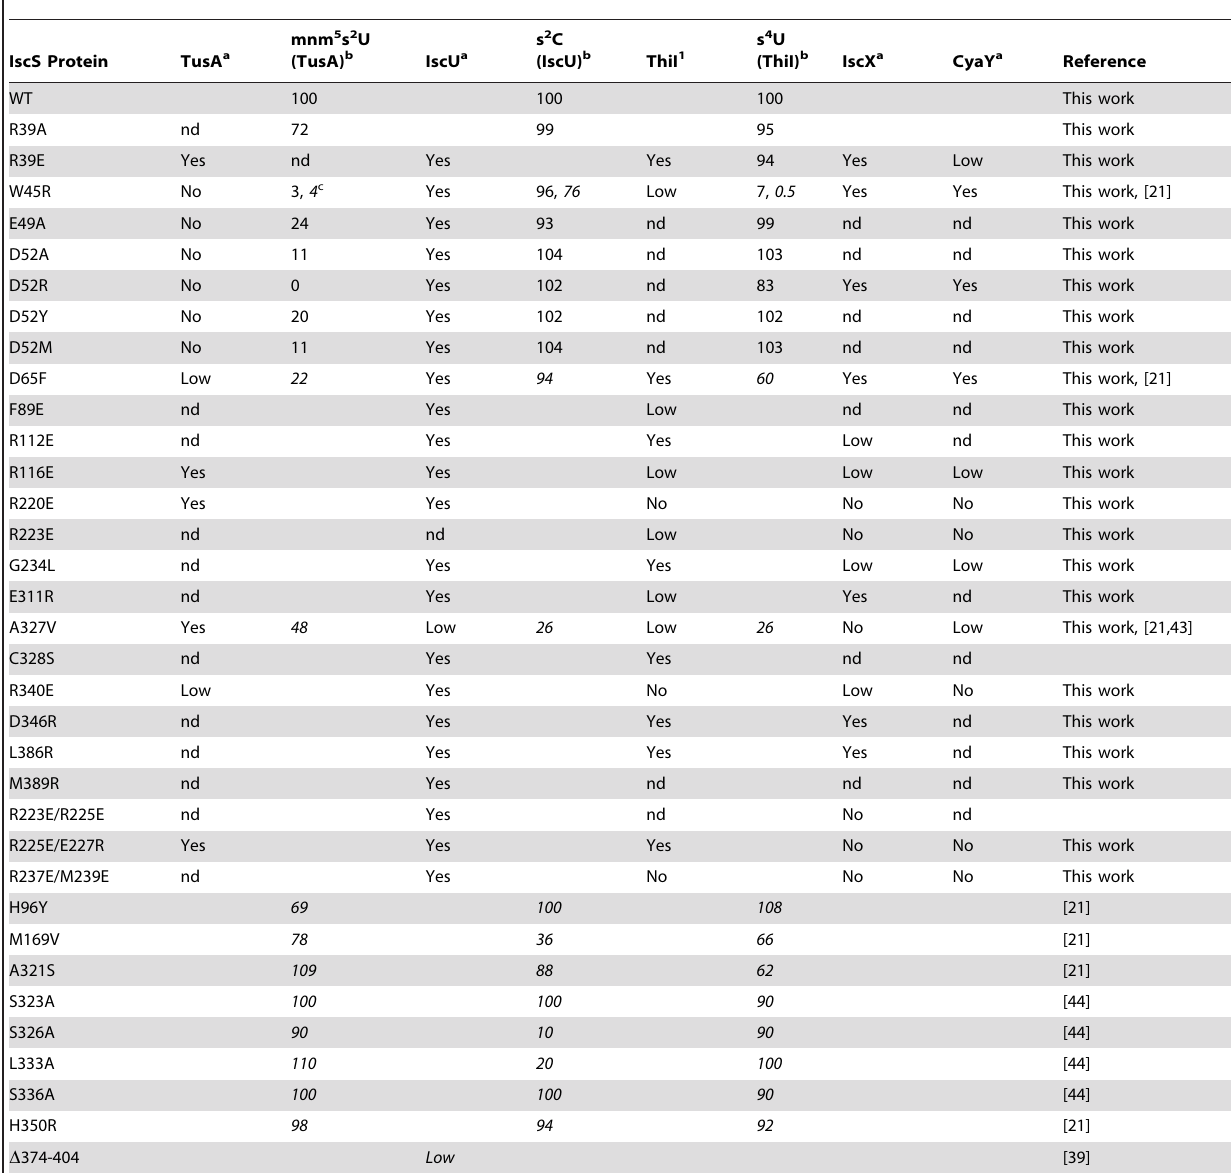
Table 3. Properties of IscS mutant proteins as assessed from pull-down and in vivo complementation experiments.